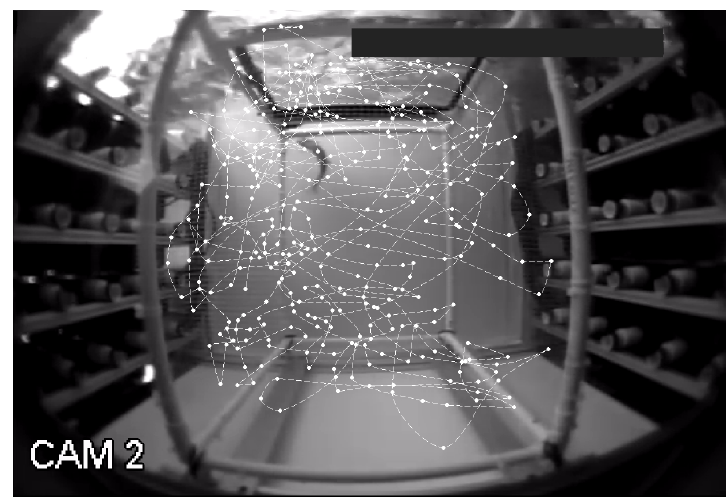
Figure 3. Fish track of a representative 2-min turbulence test captured from surveillance video footage. The location of the center of the fish, recorded every 0.3 s, is indicated with a white circle and the interpolated fish track is indicated with a dashed